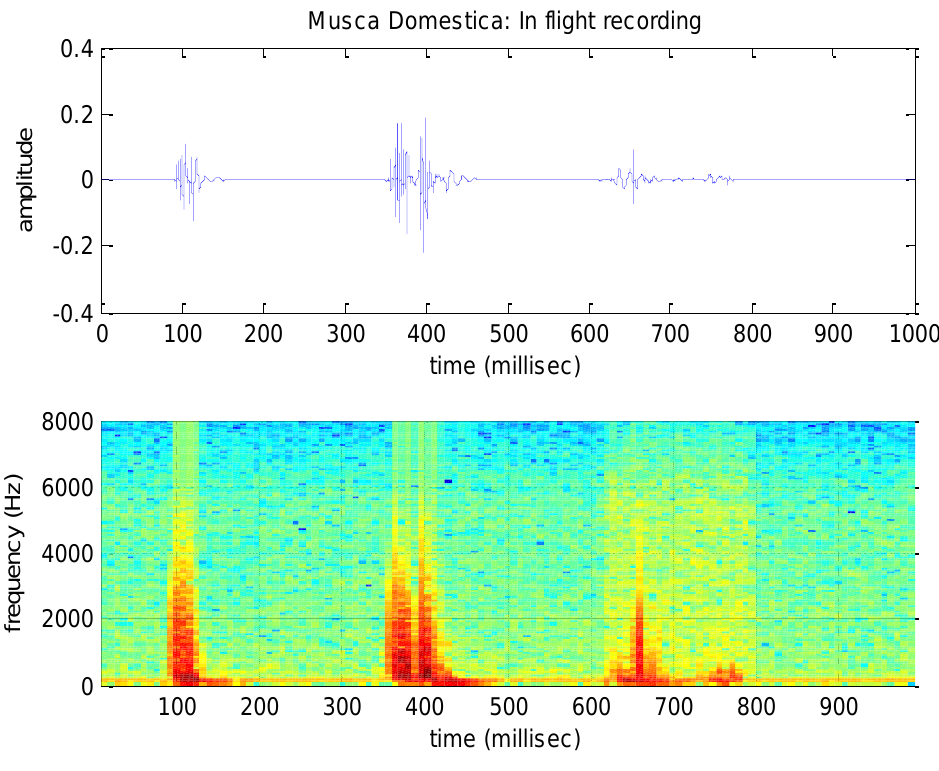
Figure 11. A series of in-flight recordings for Musca domestica . The flight time to cross the beam is estimated between 50 and 100 msec.